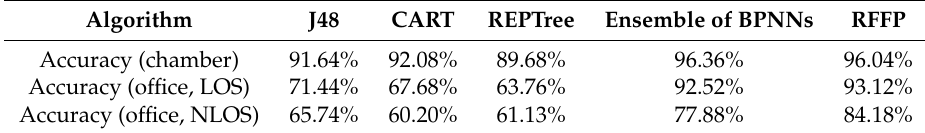
Table 2. Performance comparison between different wireless channel circumstances.